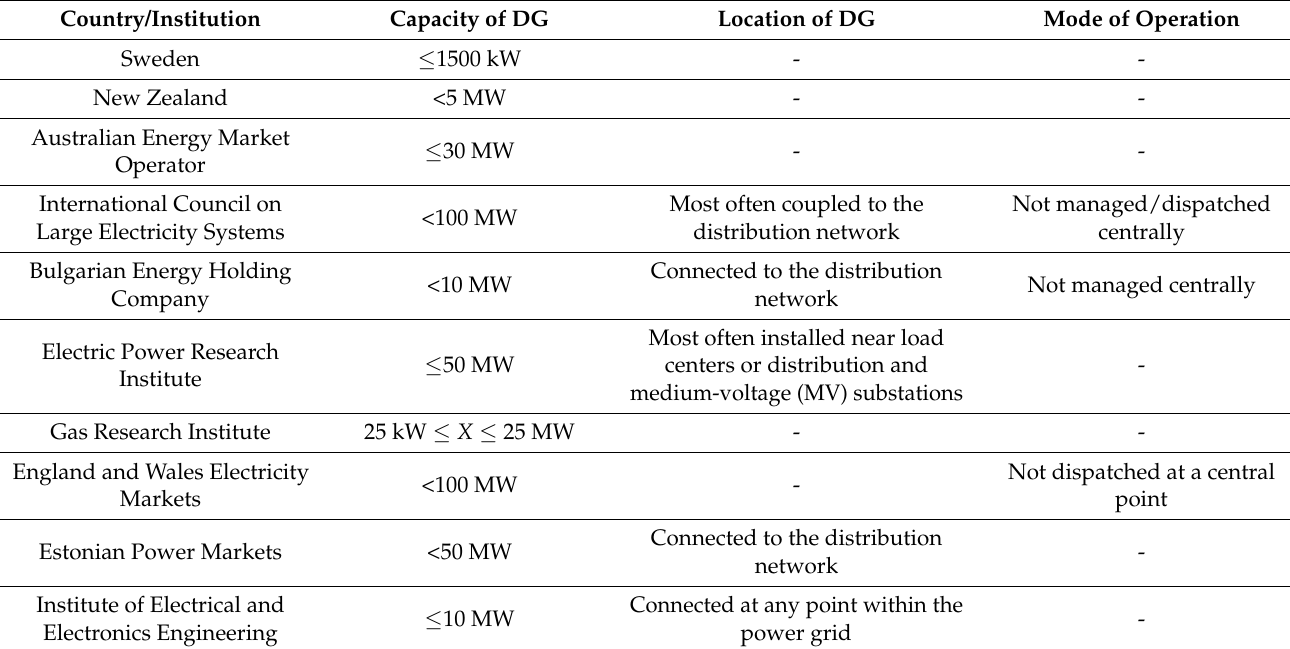
Table 1. Classification of DGs by some countries/institutions